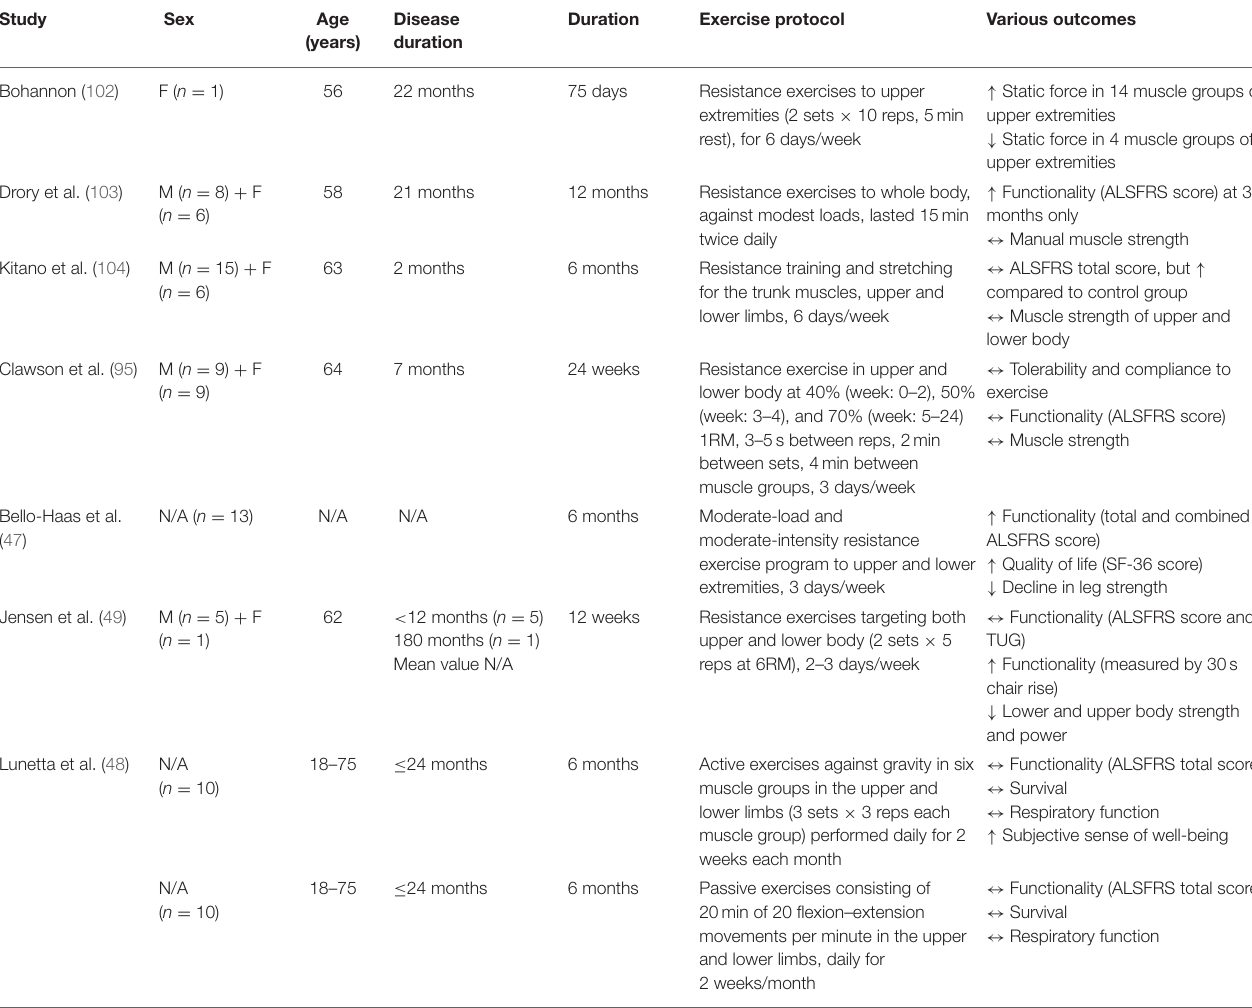
TABLE 4 | Summary of the effects of resistance training in ALS